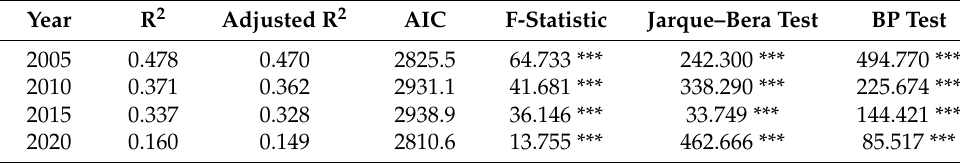
Table 4. OLS model fit results.